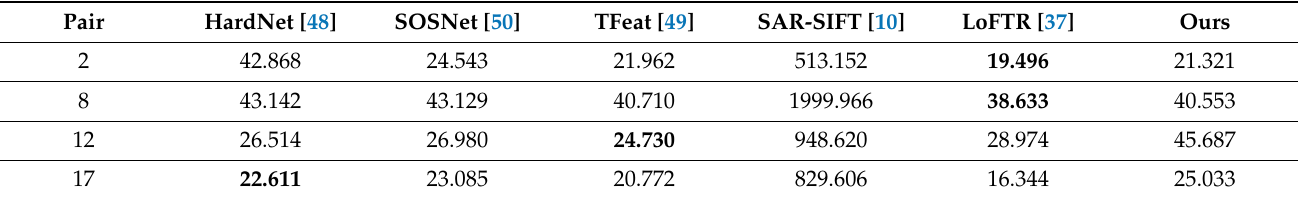
Table 4. Execution time (s) comparison of the different methods.